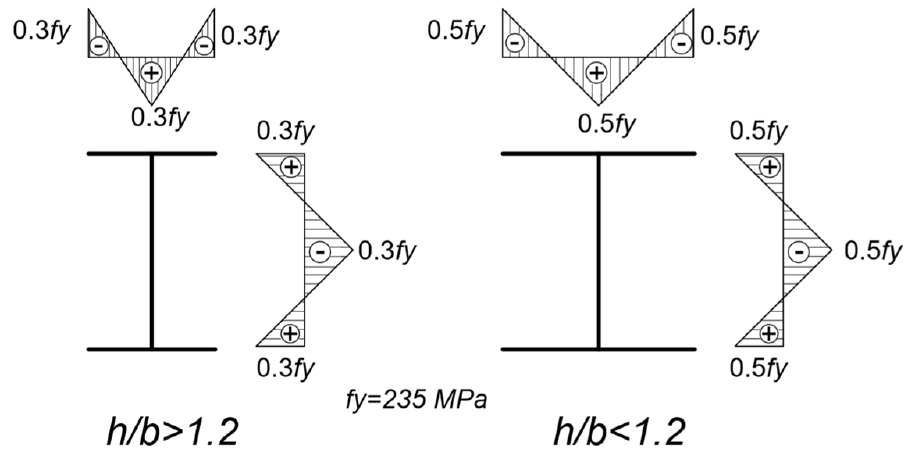
Figure 5. Distribution of residual stresses for hot rolled I and H profiles. The boundary conditions on both member ends were modelled in one “Master node”, which were located in the centre of gravity of end cross-sections, and these nodes were shifted 1 mm away from them. Therefore, the lengths of the members were shorter by 2 mm. These master nodes were modelled by one node element, MASS 21, which has six degrees of freedom. The master nodes were coupled to all nodes of end cross-sections by “constraint equations” in a such way that they behaved like a rigid plate, and the displacements and rotations of end cross-sections were dependent on the motion of the master node. Therefore, it was possible to apply the boundary conditions and loads directly to one node, simplifying the modelling process. This also compensates for modelling material zones in the ends of the member with the higher value of Young’s modulus of elasticity [29], which prevents the development of stress concentrations under concentrated loads. As there is also analysis of IPE members with free warping of the end cross-sections in this paper, a different modelling technique of such boundary conditions is explained later in the paper.